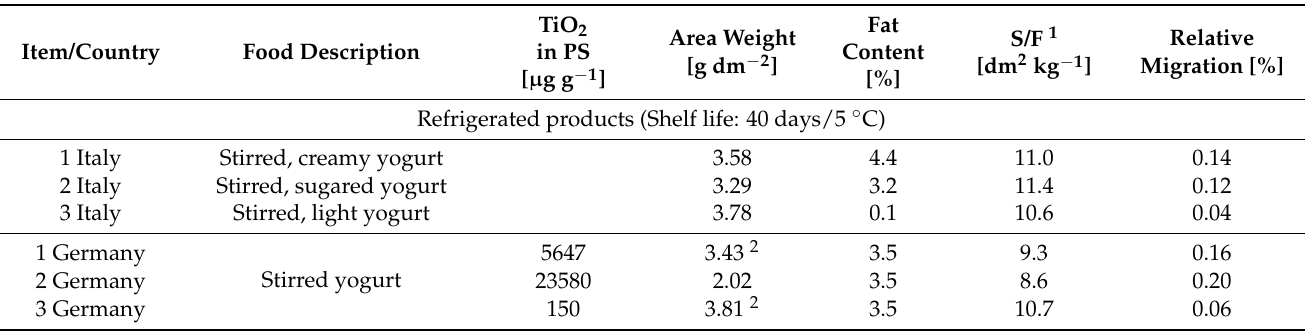
Table 5. Relative migration of styrene at BBD and main characteristics of the investigated products (food and